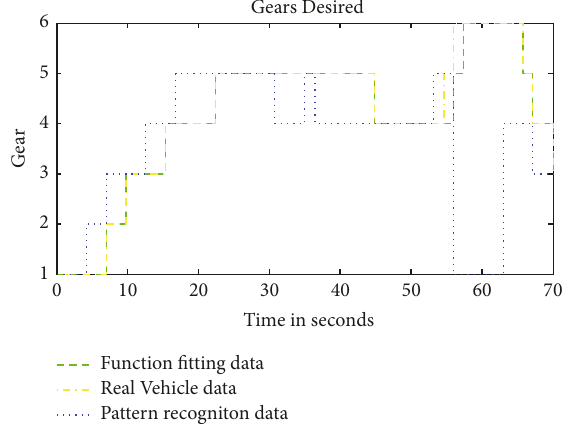
Figure 24: Gear timing of road test